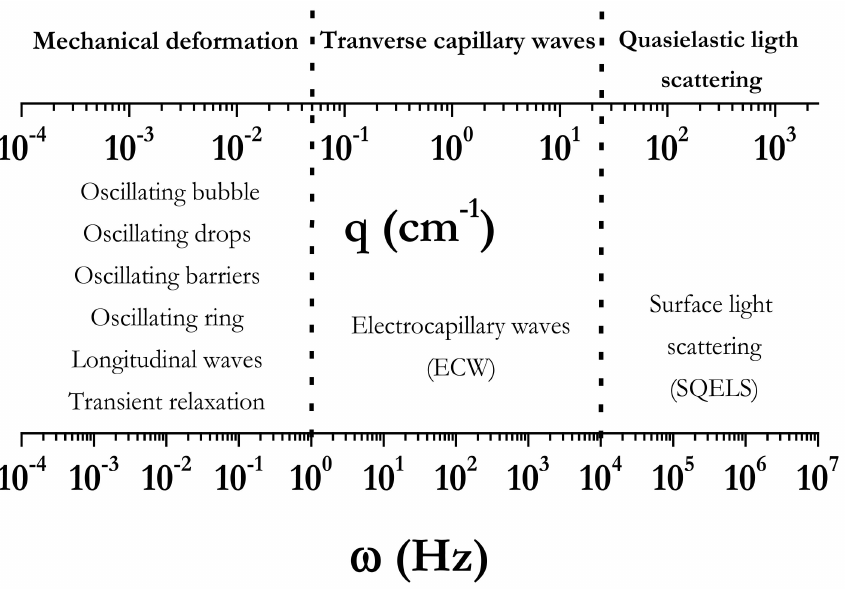
Figure 4. Summary of some of the most extended methodologies for evaluating the dilational response of fluid/fluid interface, together with the accessible frequency ranges for such